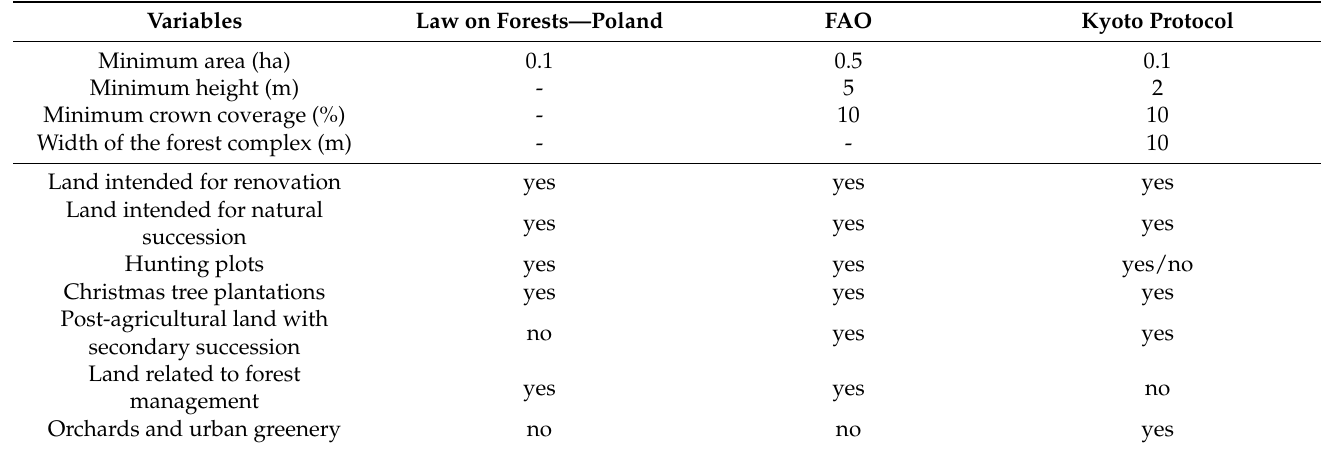
Table 2. Criteria for delimiting forest